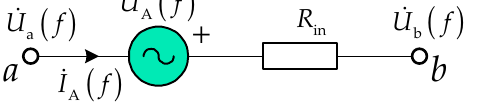
Figure 6. Schematic of the test voltage source.